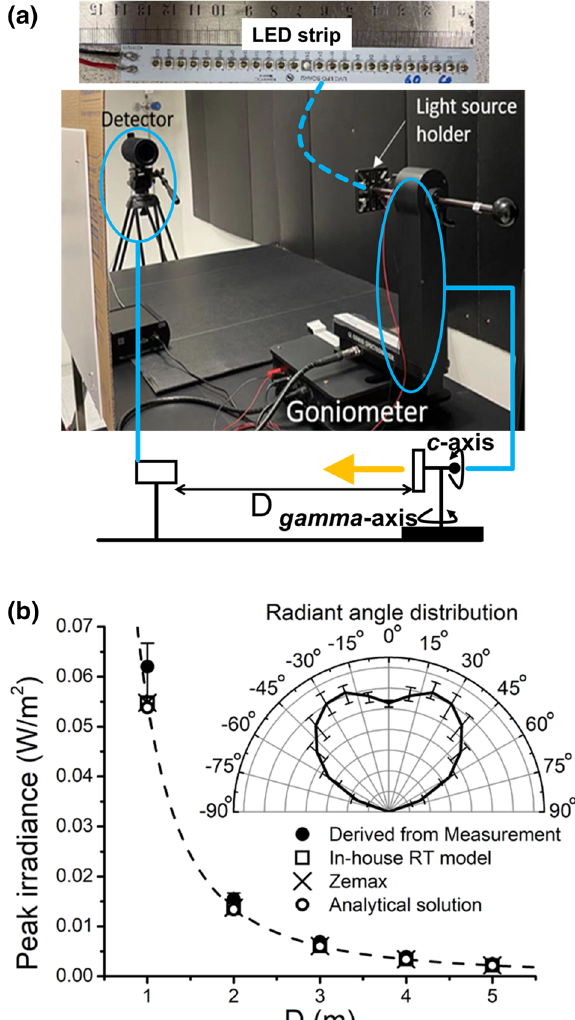
Figure 3. ( a ) The picture of the experimental setup and the schematic illustration for measuring the radiation emitted by LED strips are shown. ( b ) The model validation by comparing the peak irradiance derived from the measurement and the simulation done by the in-house-developed RT model, Zemax OpticStudio, and the analytical solution. The inset in ( b ) shows the angular radiation pattern of a single LED. The error bars comes from the standard deviation of the average in c